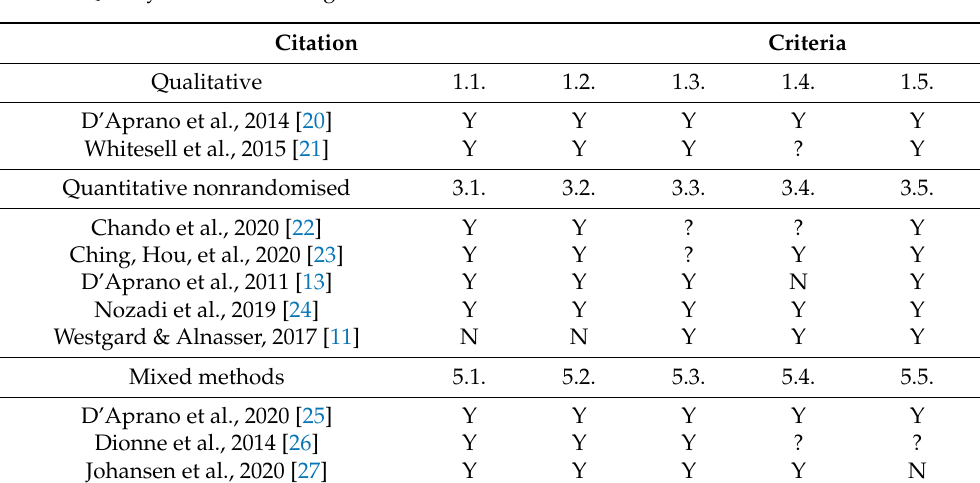
Table 2. Quality assessment using